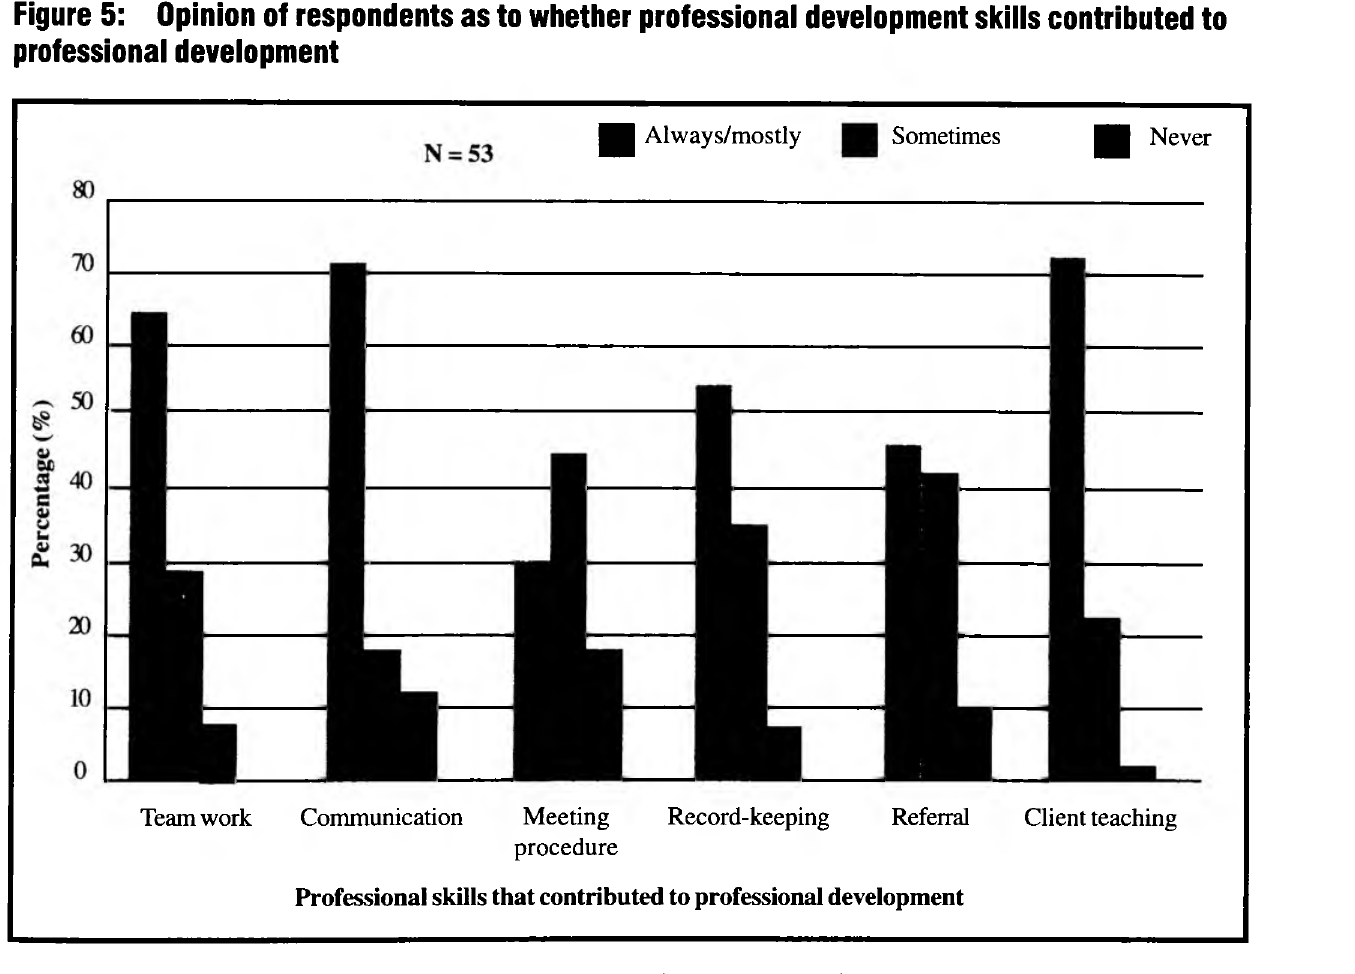
Figure 5: Opinion of respondents as to whether professional development skills contributed to professional